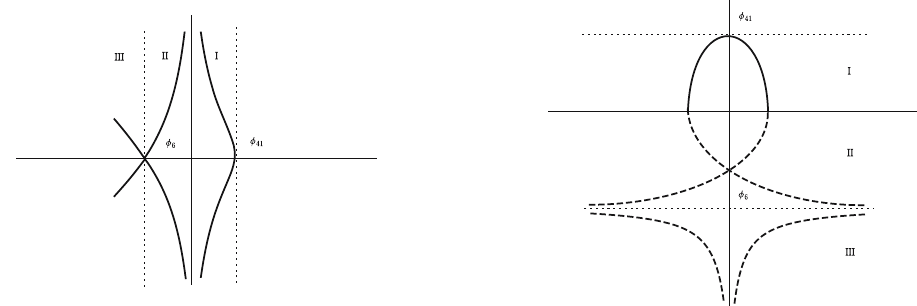
, one positive roots ϕ 6 41